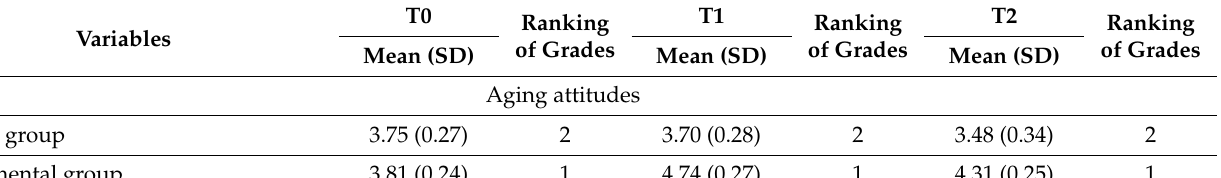
Table 3. Scores for individual items of the Attitudes to Ageing Questionnaire, the hope Herth index, and the hand–eye coordination